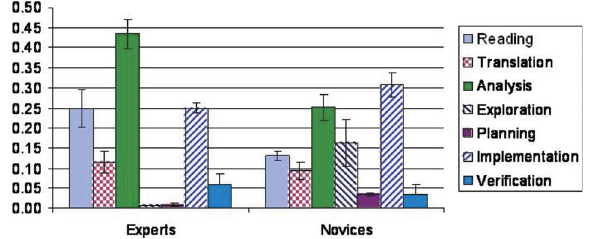
FIG. 11. (cid:1) Color online (cid:2) Distribution of time spent in by experts and novices during their solutions to the electrostatics problems. The possibility of coding more than one behavior per interval leads to totals above 1.0. Error bars represent the standard error of